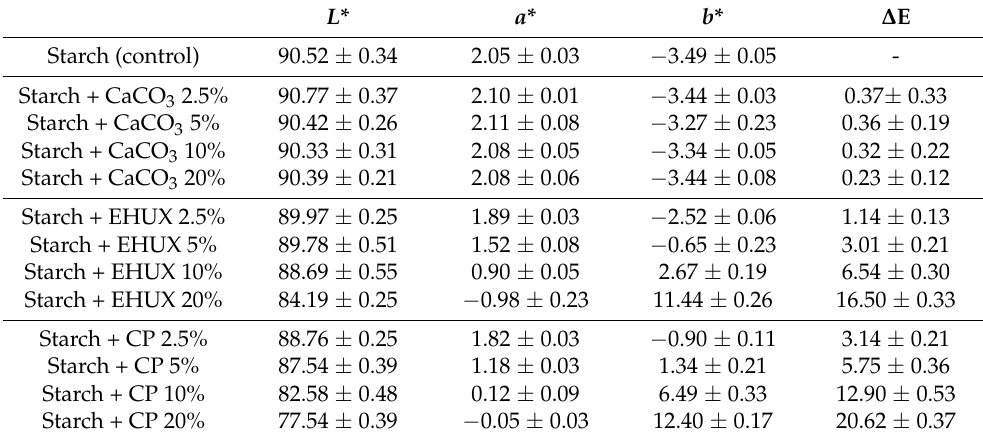
Table 1. Values (mean ± standard deviation) for lightness ( L *), red-green ( a *), yellow-blue ( b *), and total colour variation ( ∆ E) of starch films (control) and starch-based films containing commercial CaCO 3 , E. huxleyi (EHUX) or C. pseudoroscoffensis (CP) at different percentages (2.5, 5, 10, and 20% w / w ). L * a * b * ∆ E Starch